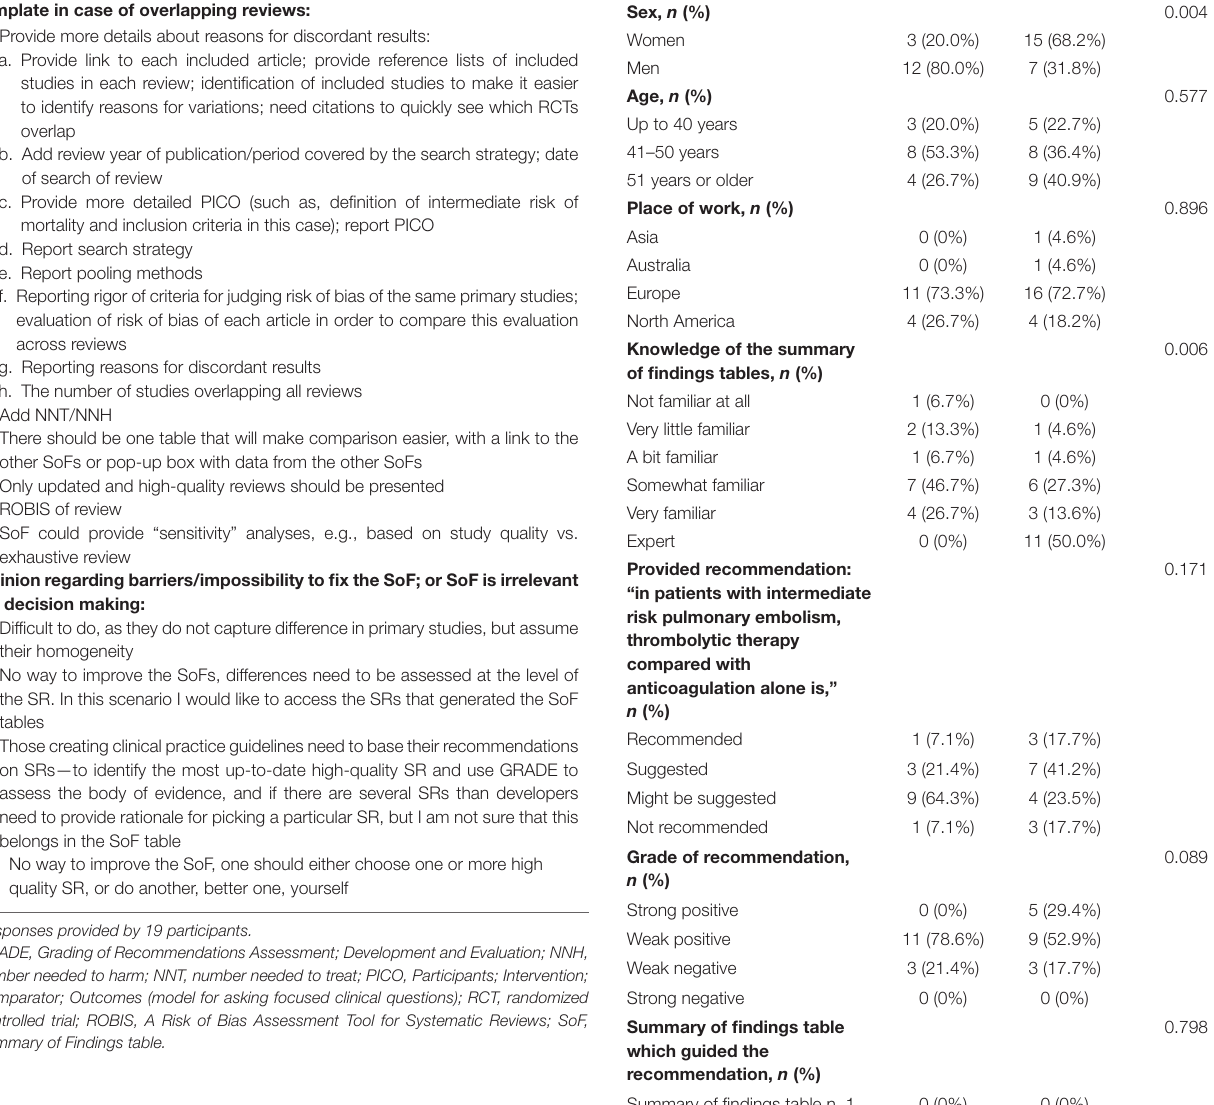
TABLE 4 | Differences in responses between clinicians and